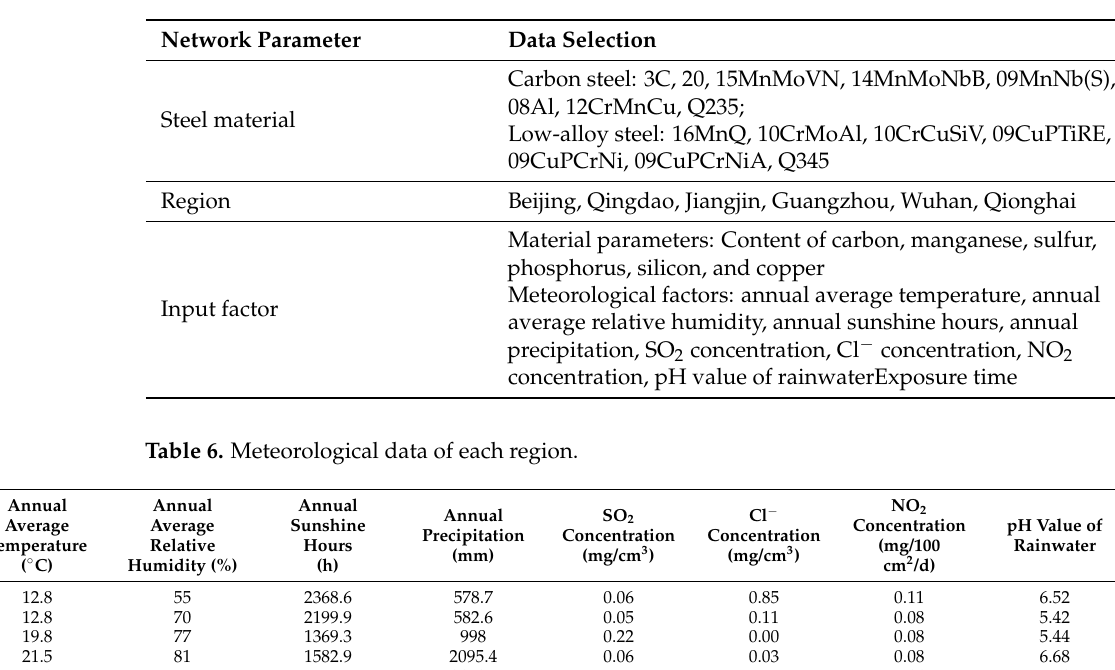
Table 6. Meteorological data of each region. Table 5. Data selection for the artificial neural network model.